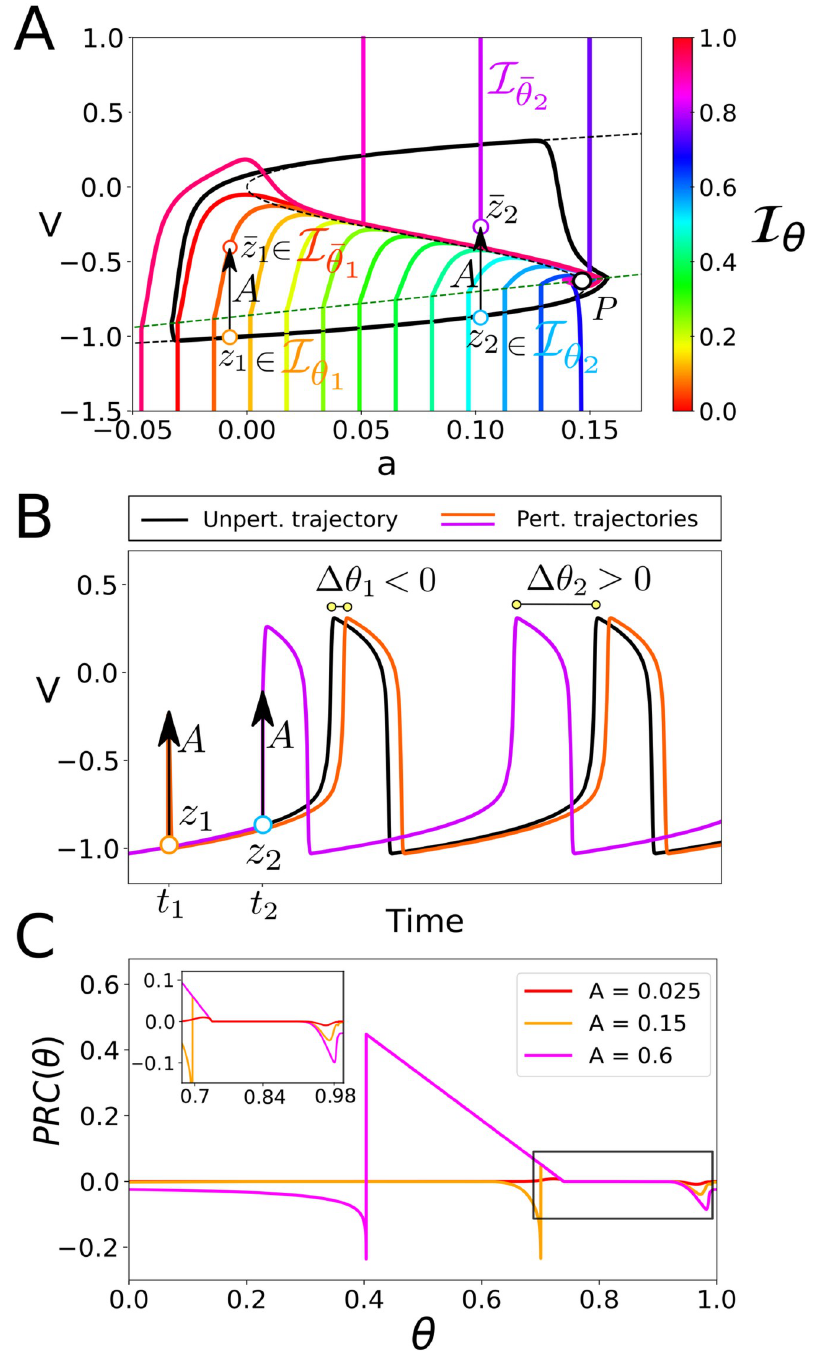
Fig 3. Isochrons and PRCs for the phenomenor model (7). Panel (A) shows the limit cycle Γ isochrons, the v and a nullclines (dashed black and green curves, respectively) and the fixed point, P , at their intersection. The distribution of isochrons clarifies the time dependency of perturbations: as panel (B) shows, a pulse of amplitude A applied at a time t 1 ( t 2 ) causes a negative (positive) phase shift, delaying (promoting) the transition to seizure. This time dependency can be directly inferred from panel (A): a pulse of amplitude A applied at a point on the cycle z 1 = γ ( θ 1 ) = γ ( t 1 / T ) ( z 2 = γ ( θ 2 ) = γ ( t 2 / T )) displaces the trajectory to a point � z ( � y > y ) the perturbation causes a phase shift D y 2 2 phase of the oscillator. The panel (C) shows the PRCs for the phenomenor for positive voltage pulses of different amplitudes summarising the timing (phasic) effect of a given